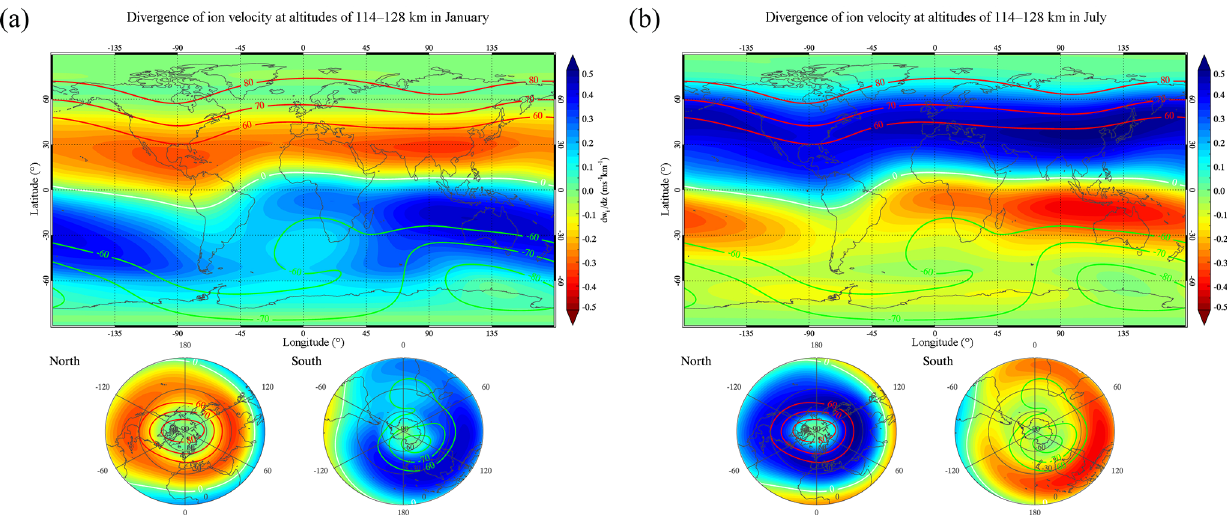
Figure 9. Same as Fig. 8 but for the altitude range between 114 and 128km in January (a) and July (b)